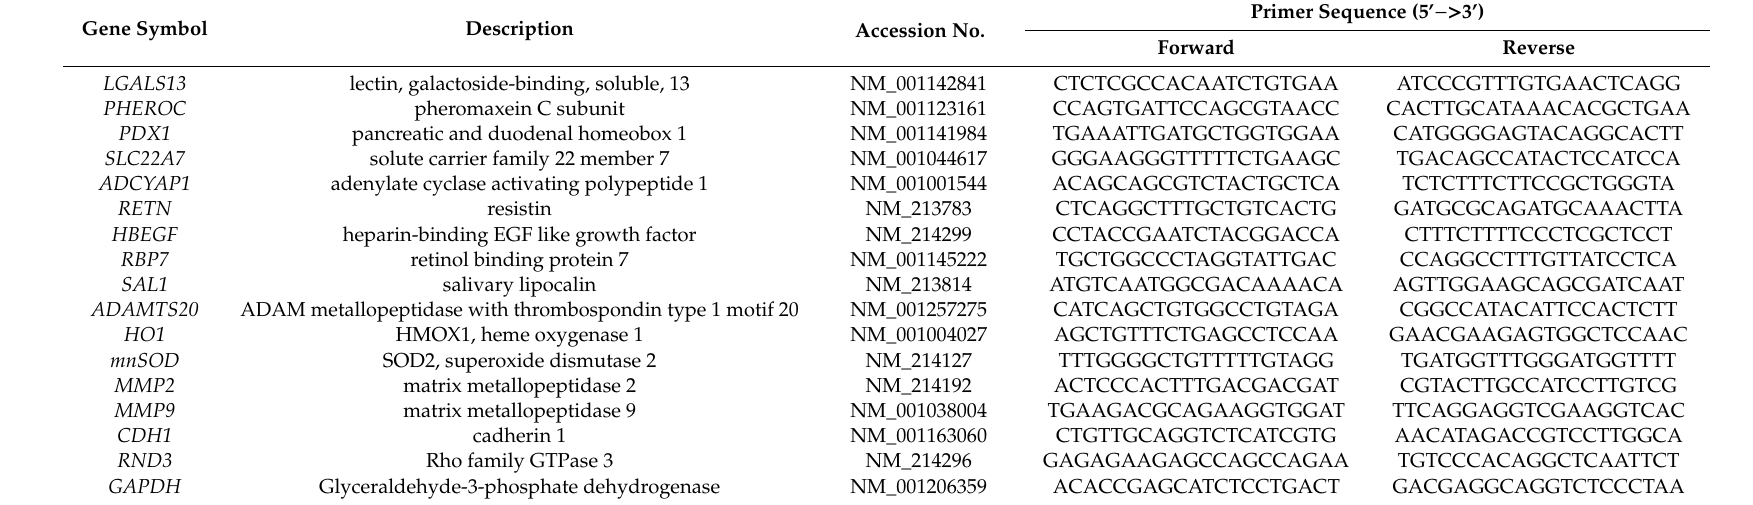
Table 1. List of